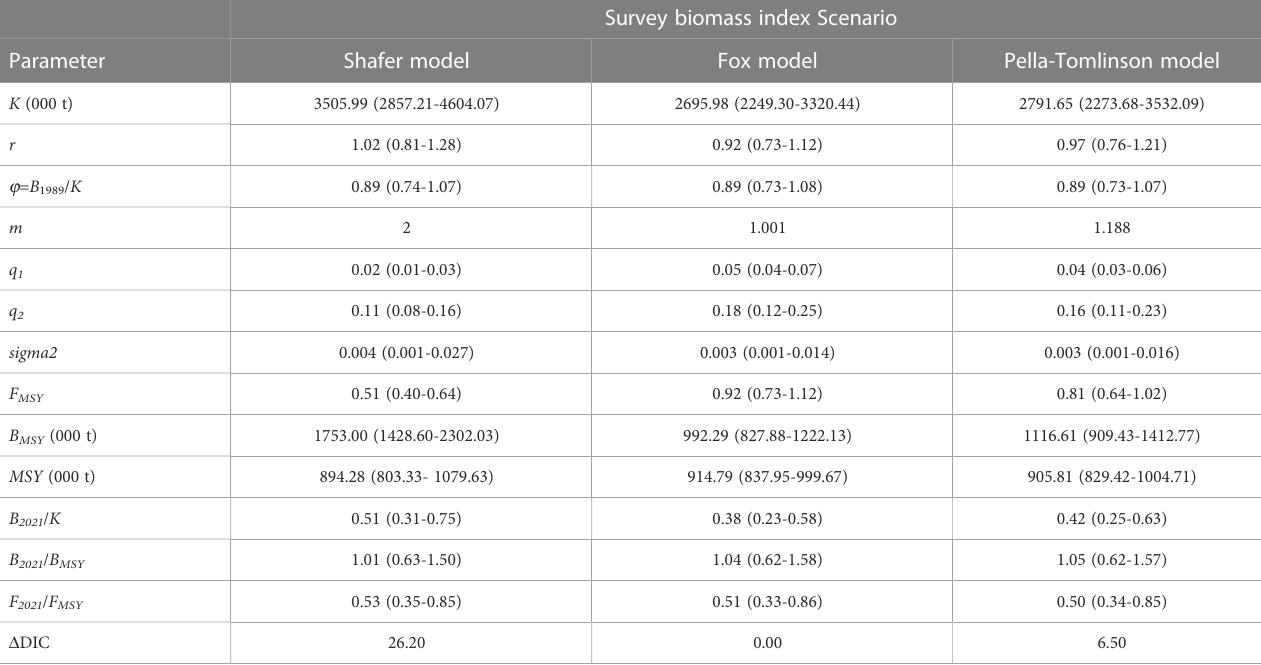
TABLE 1 Summary of parameter estimates and 95% Bayesian credible intervals (showed in parentheses) from the JABBA scenario based on the Small yellow croaker scienti fi c survey